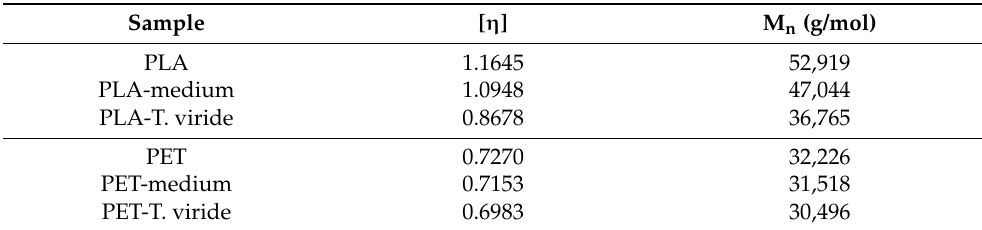
Table 2. The values of intrinsic viscosity ([ η ]) and number average molecular weight ( M n ). Sample